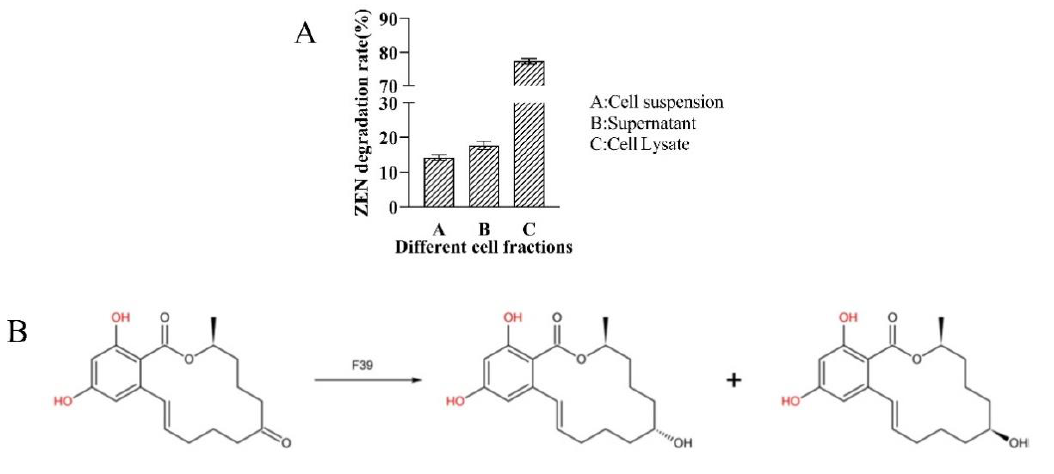
Figure 4. ZEN degradation by different cell components of F39 ( A ) and one possible route of ZEN degradation ( B ).